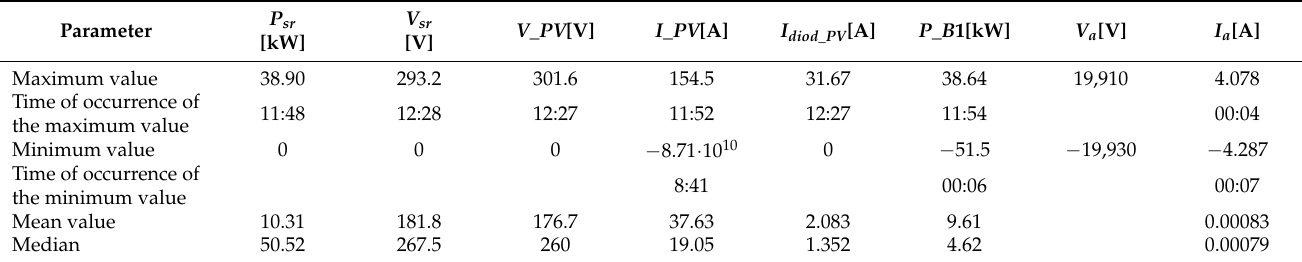
Table 6. Values of parameters of the PV installation on a sample day in